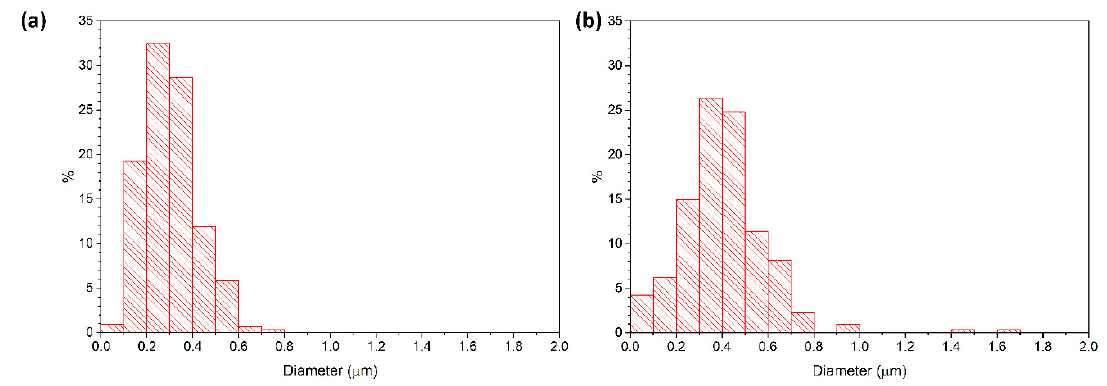
Figure 9. SEM micrographs of ( a ) a two-step sintered sample (T1 = 1400 °C, T2 = 1350 °C, t2 = 5 h) and ( b ) a conventionally sintered sample, both prepared using ball milled powder.